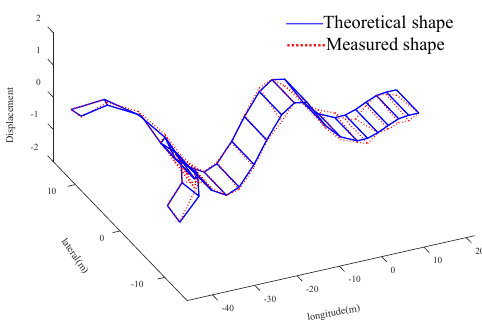
Figure 23. Comparison of the shape of 3rd (cid:108) .